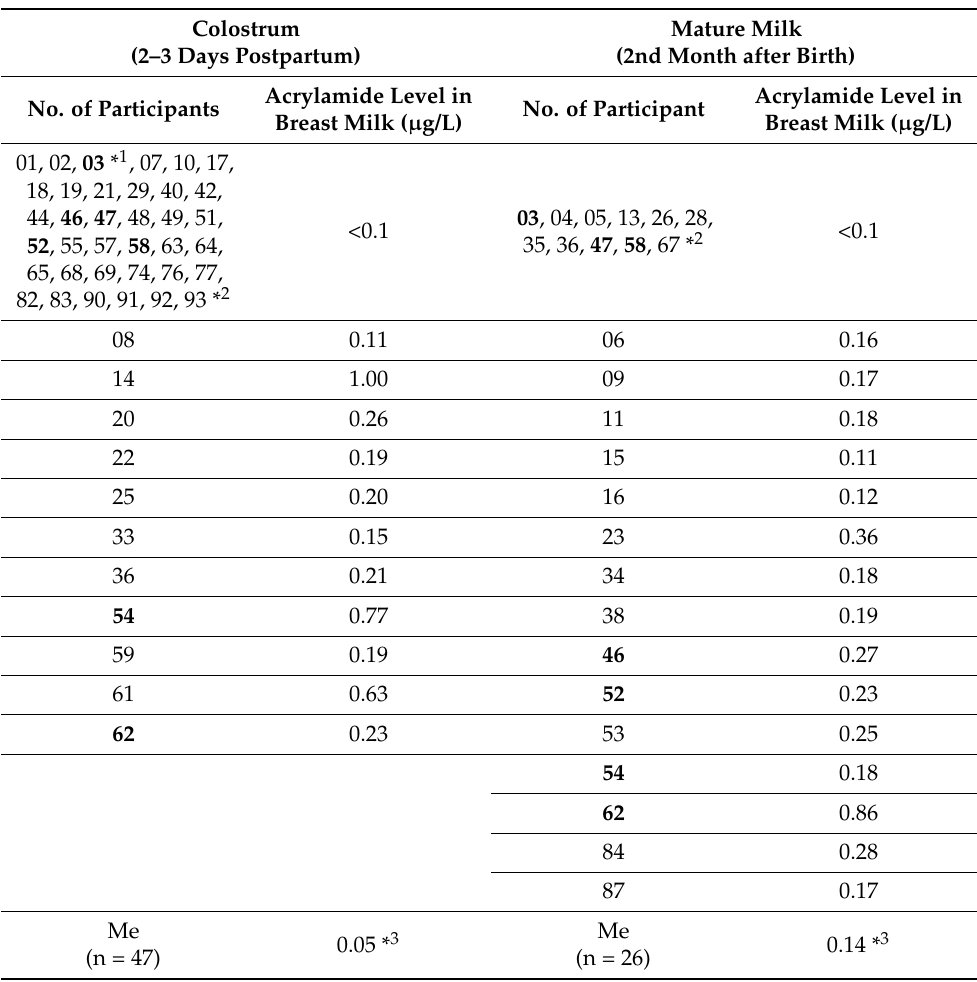
Table 2. Acrylamide level in breast milk